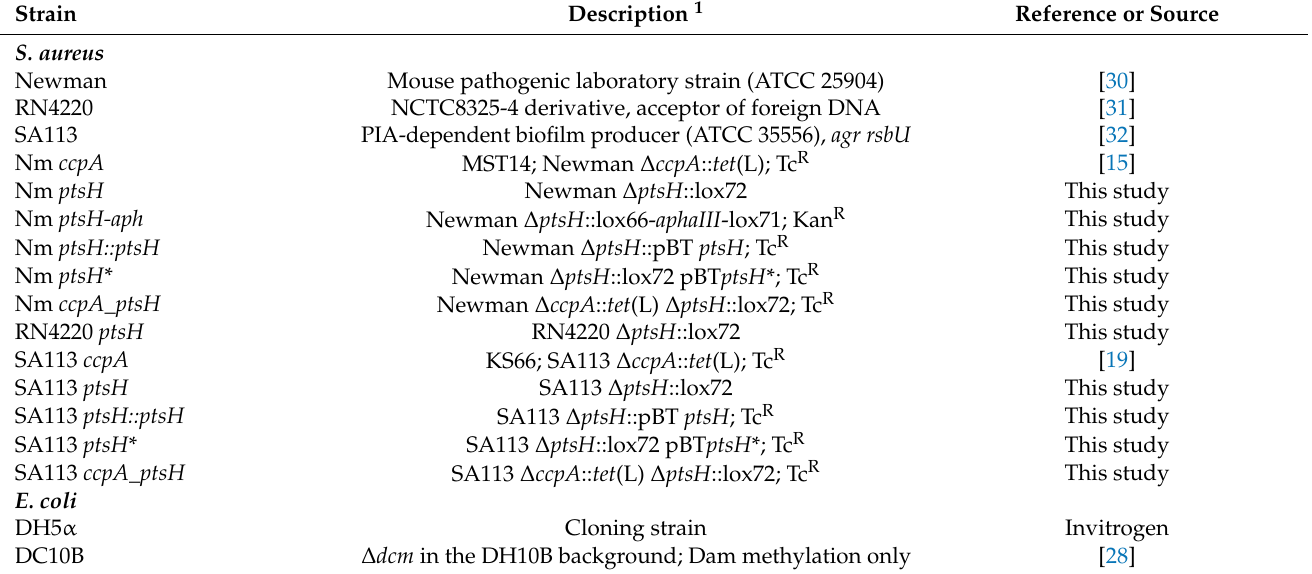
Table 1. Strains and plasmids used in this